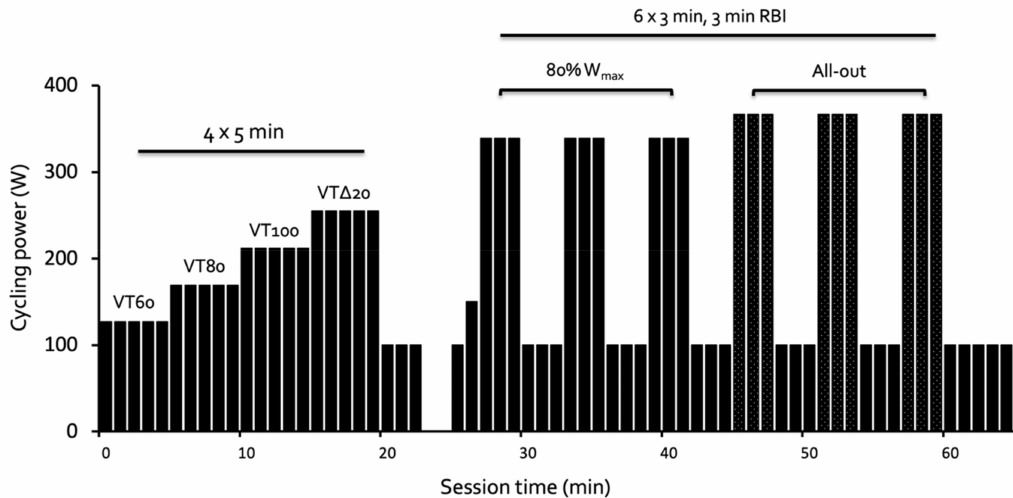
Figure 1. Schematic overview of cycle testing sessions using wattage from an example participant. The 5-min intervals were performed at intensities equivalent to 60%, 80%, and 100% of their ventilatory threshold (VT 60, VT80, VT100, respectively), and 20% of the difference between the ventilatory threshold and peak power (W max , VT ∆ 20), followed by a 3-min cool down at 100 W. The 3-min intervals included a lead-in of 1 min at 100 W and 1 min at 150 W, followed by intervals 1–3 at 80% of Wmax, and intervals 4–6 performed as maximal